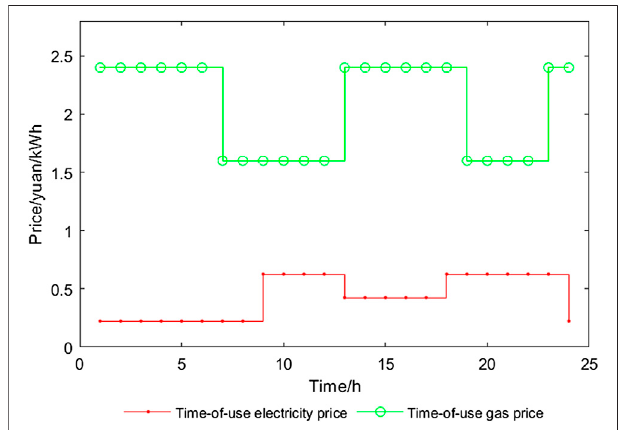
FIGURE 3 | Typical daily load on campus.